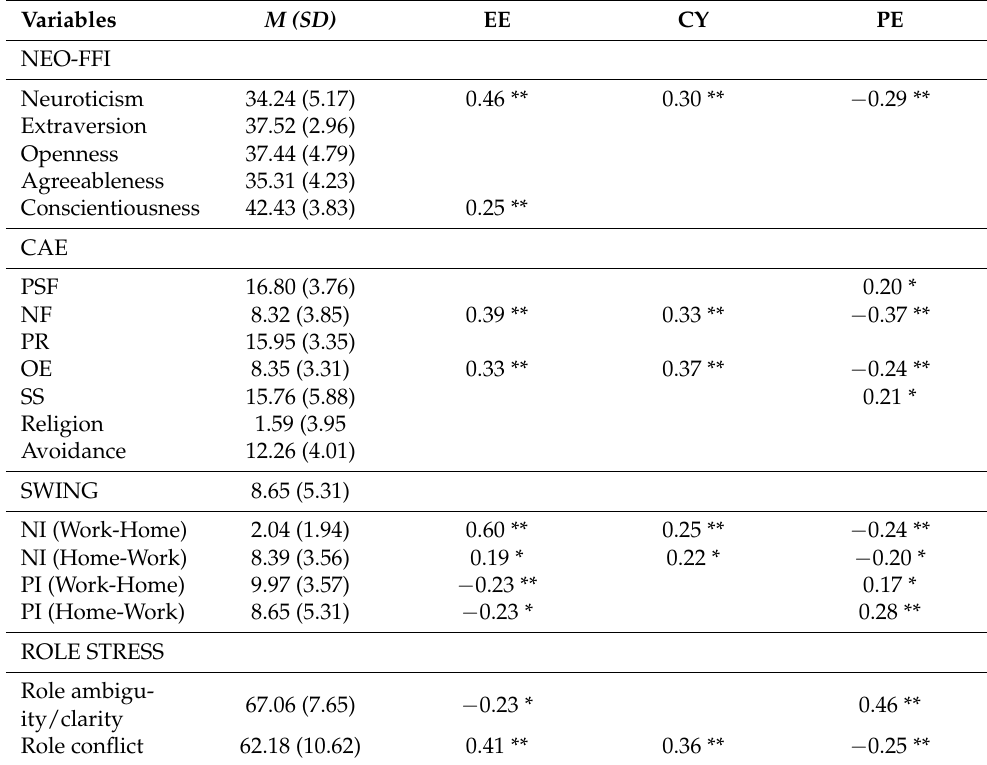
Table 2. Mean, standard deviations, and correlations between psychological, family, and work factors with the dimensions of the Maslach Burnout Inventory (MBI; n =